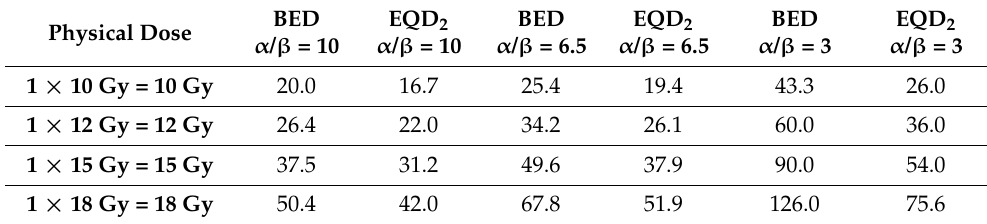
Table 4. Commutation of physical dose on BED and